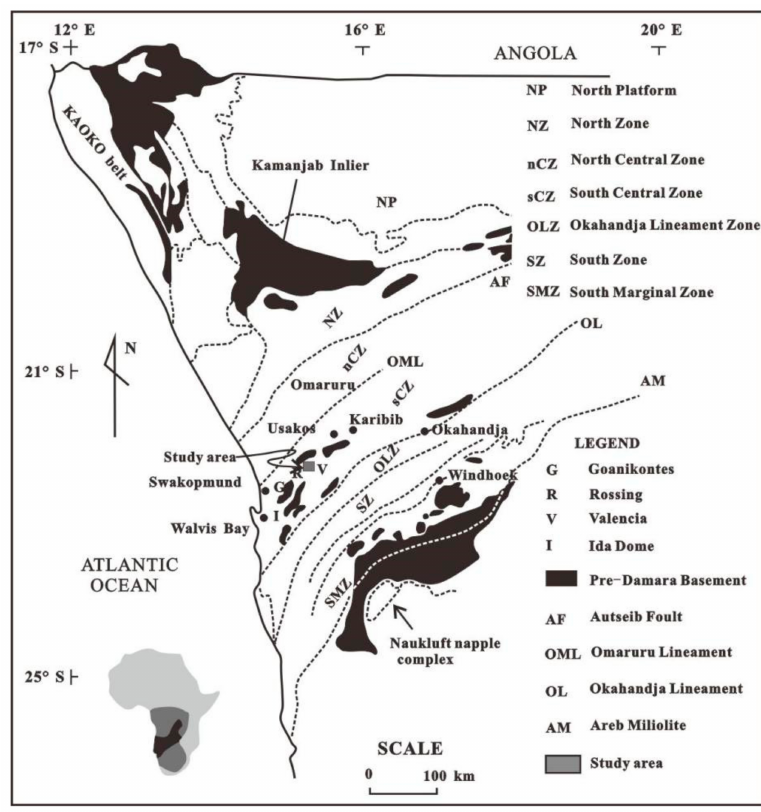
Figure 1. Map illustrating the principal subdivisions of the Damara Orogen based on Gao et al. [15] showing the location of significant uranium anomalies within the Central